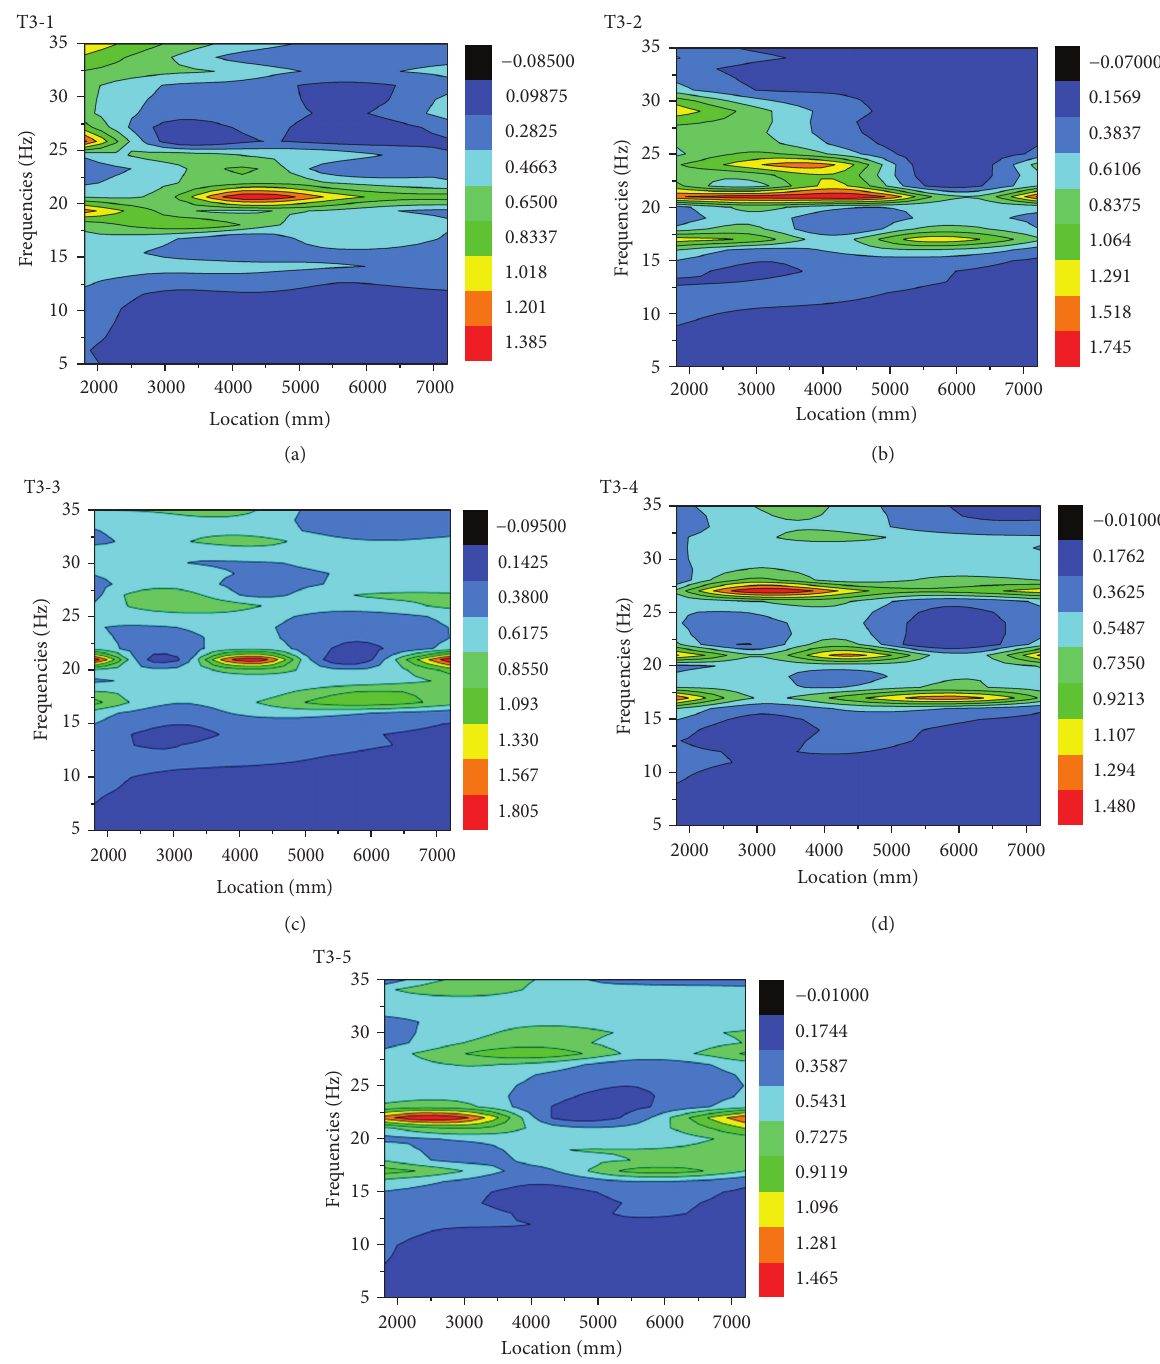
Figure 12: Transfer functions of the T3 test floors with the 600 mm joist